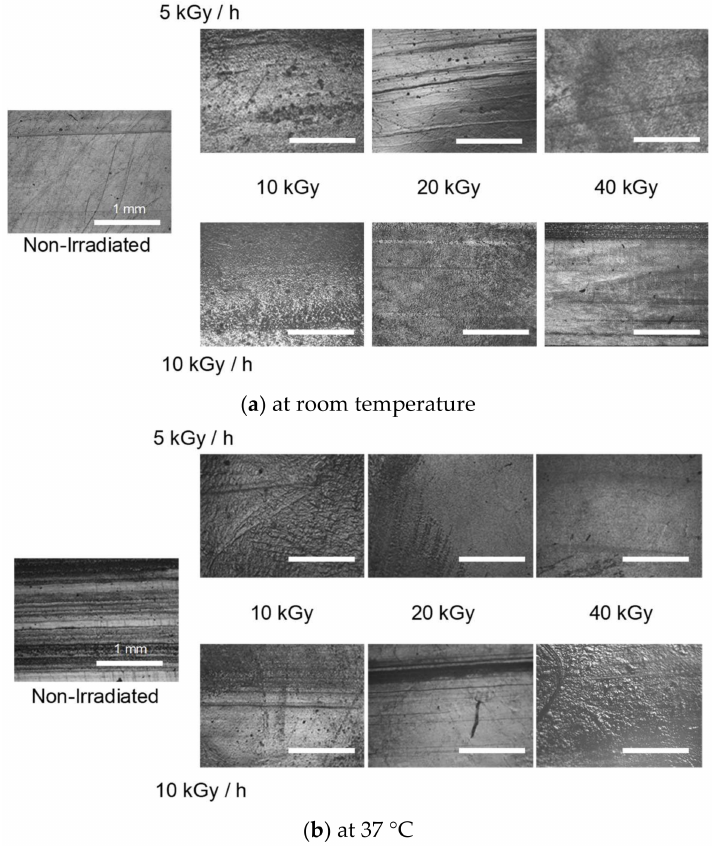
Figure 4. The photomicrograph of the surface of the gel after reciprocating friction tests at ( a ) room temperature and ( b ) body temperature. Scale bar is 1